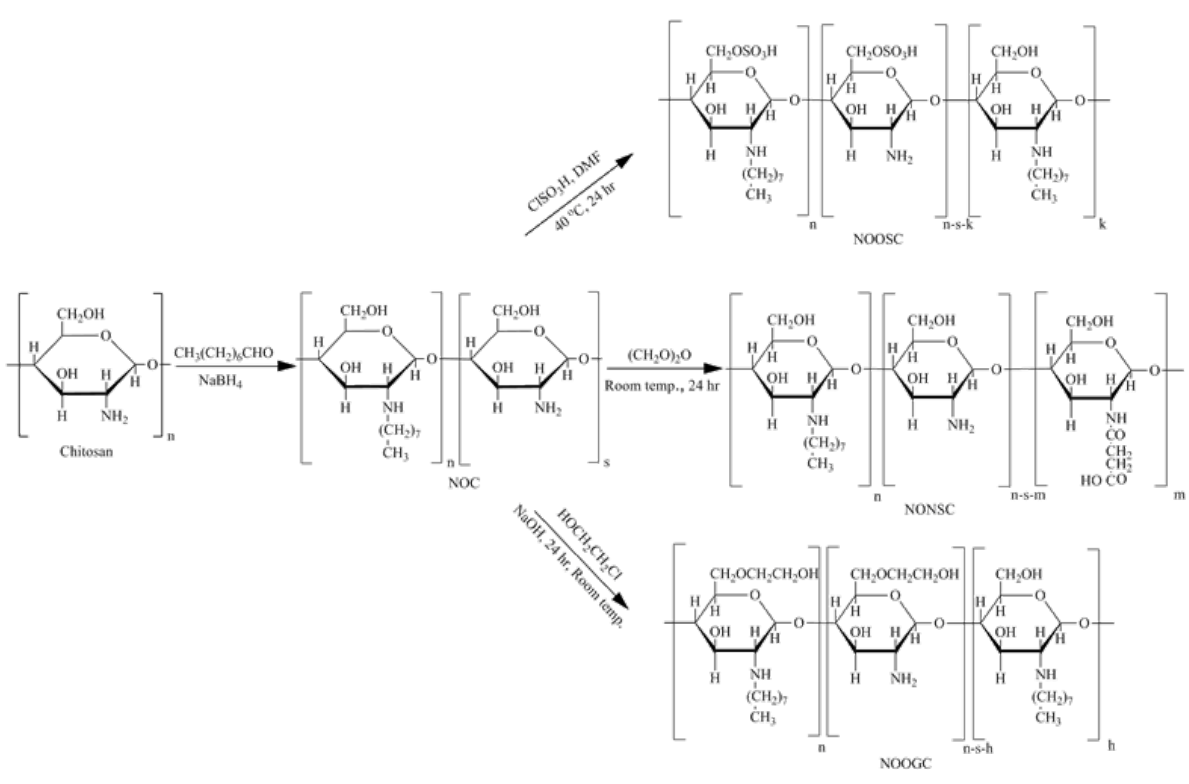
Figure 1: The synthetic scheme of N -octyl chitosan